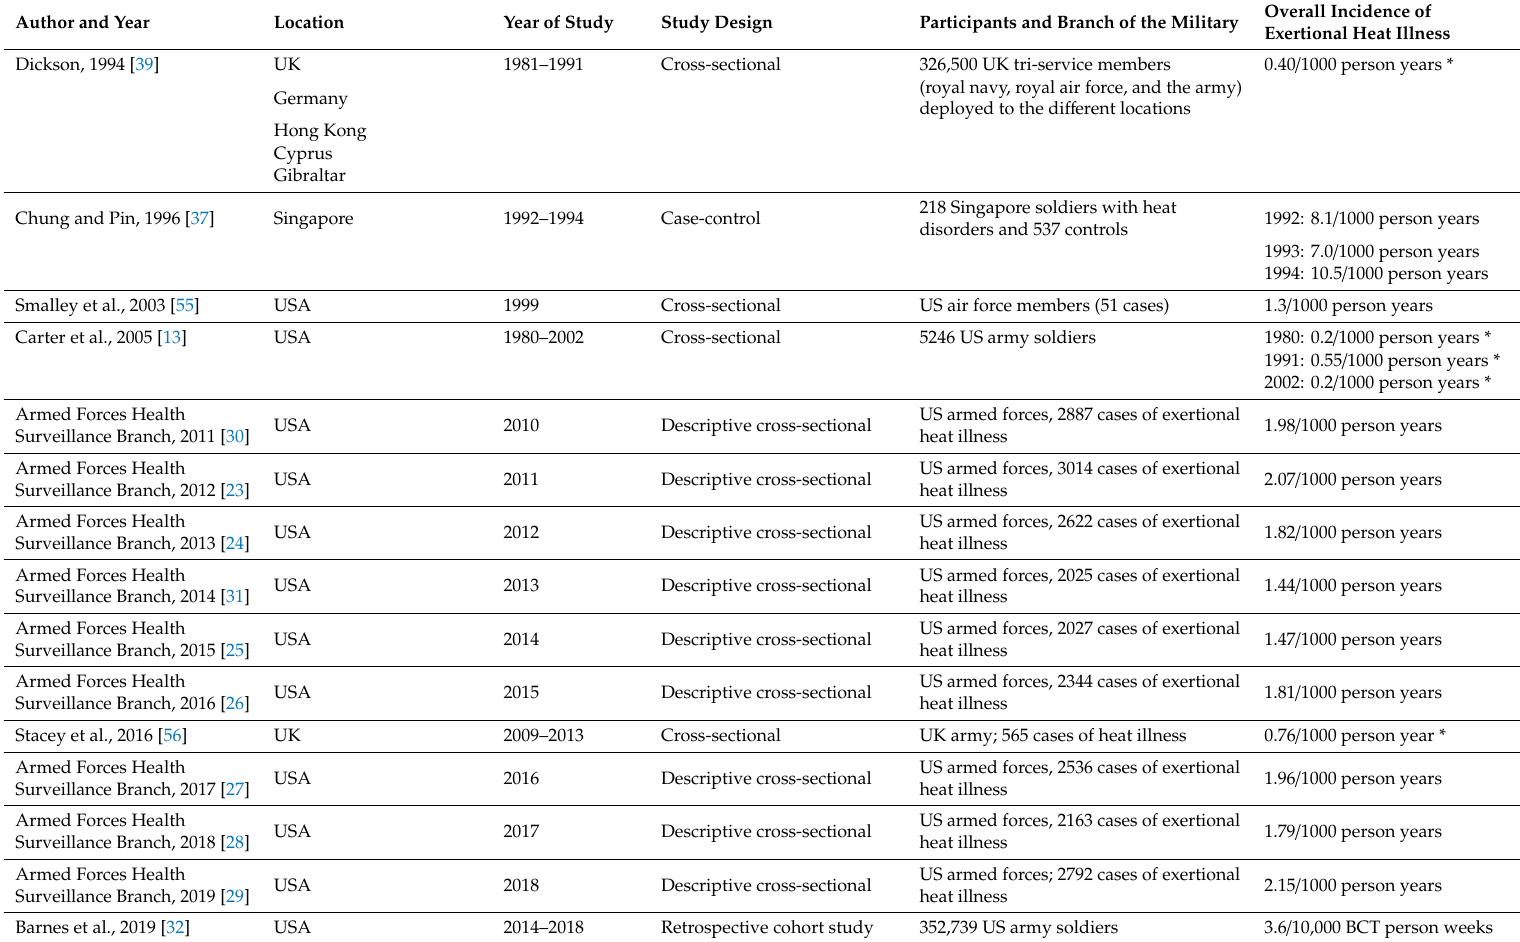
Table 1. Incidence of all exertional heat illnesses in the